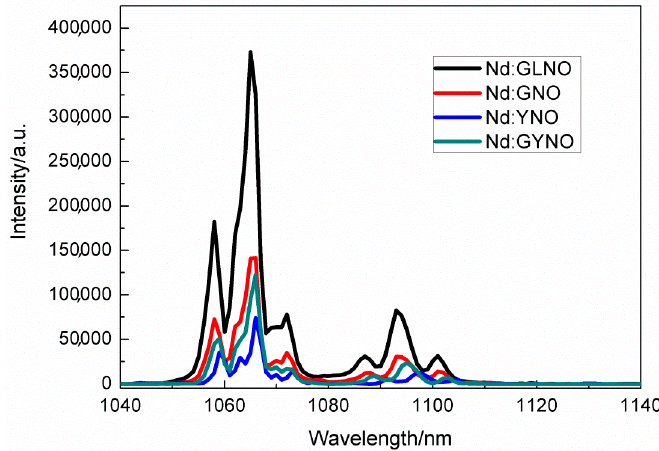
Figure 7. Emission spectra of Nd:GNO, Nd:YNO, Nd:GYNO, and Nd:GLNO crystals excited by 808 nm at room temperature.